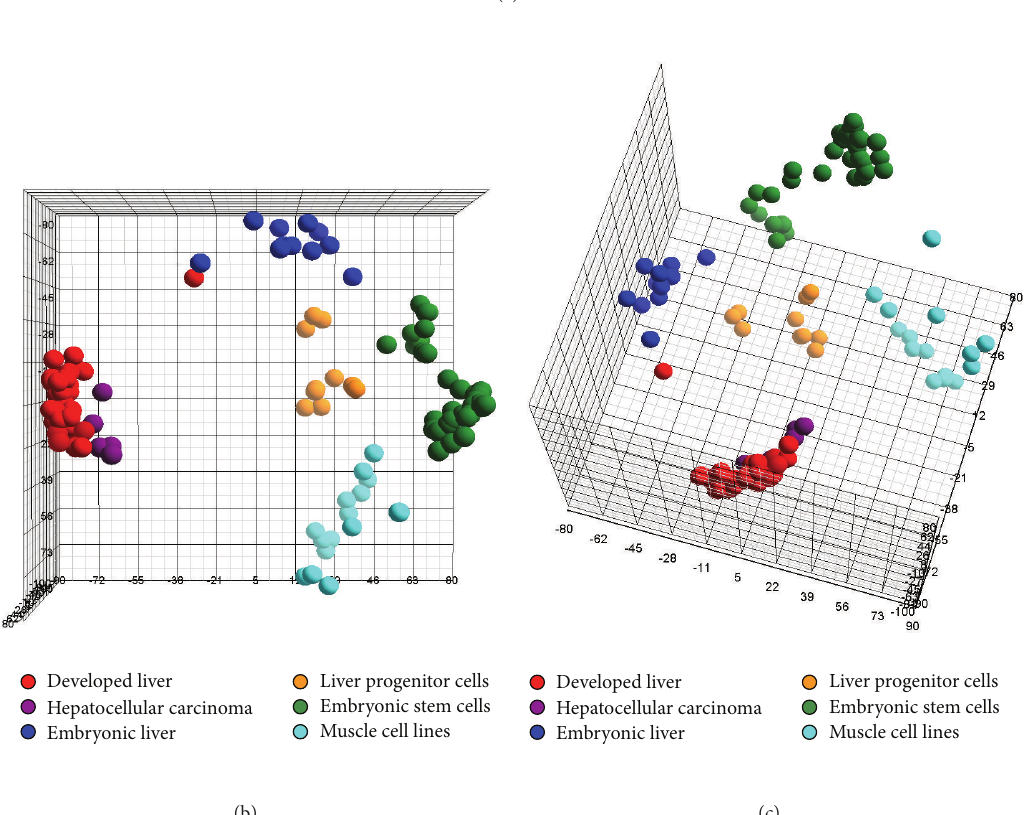
Figure 1: Principal component analysis (PCA) displays transcriptome clustering sorted by tissue type. Each node represents the average of at least 3 microarray replicates and is color-coded according to tissue type. The three principal components that captured most differences in the datasets are plotted with three different three-dimensional views of the same PCA visualization shown in (a), (b), and